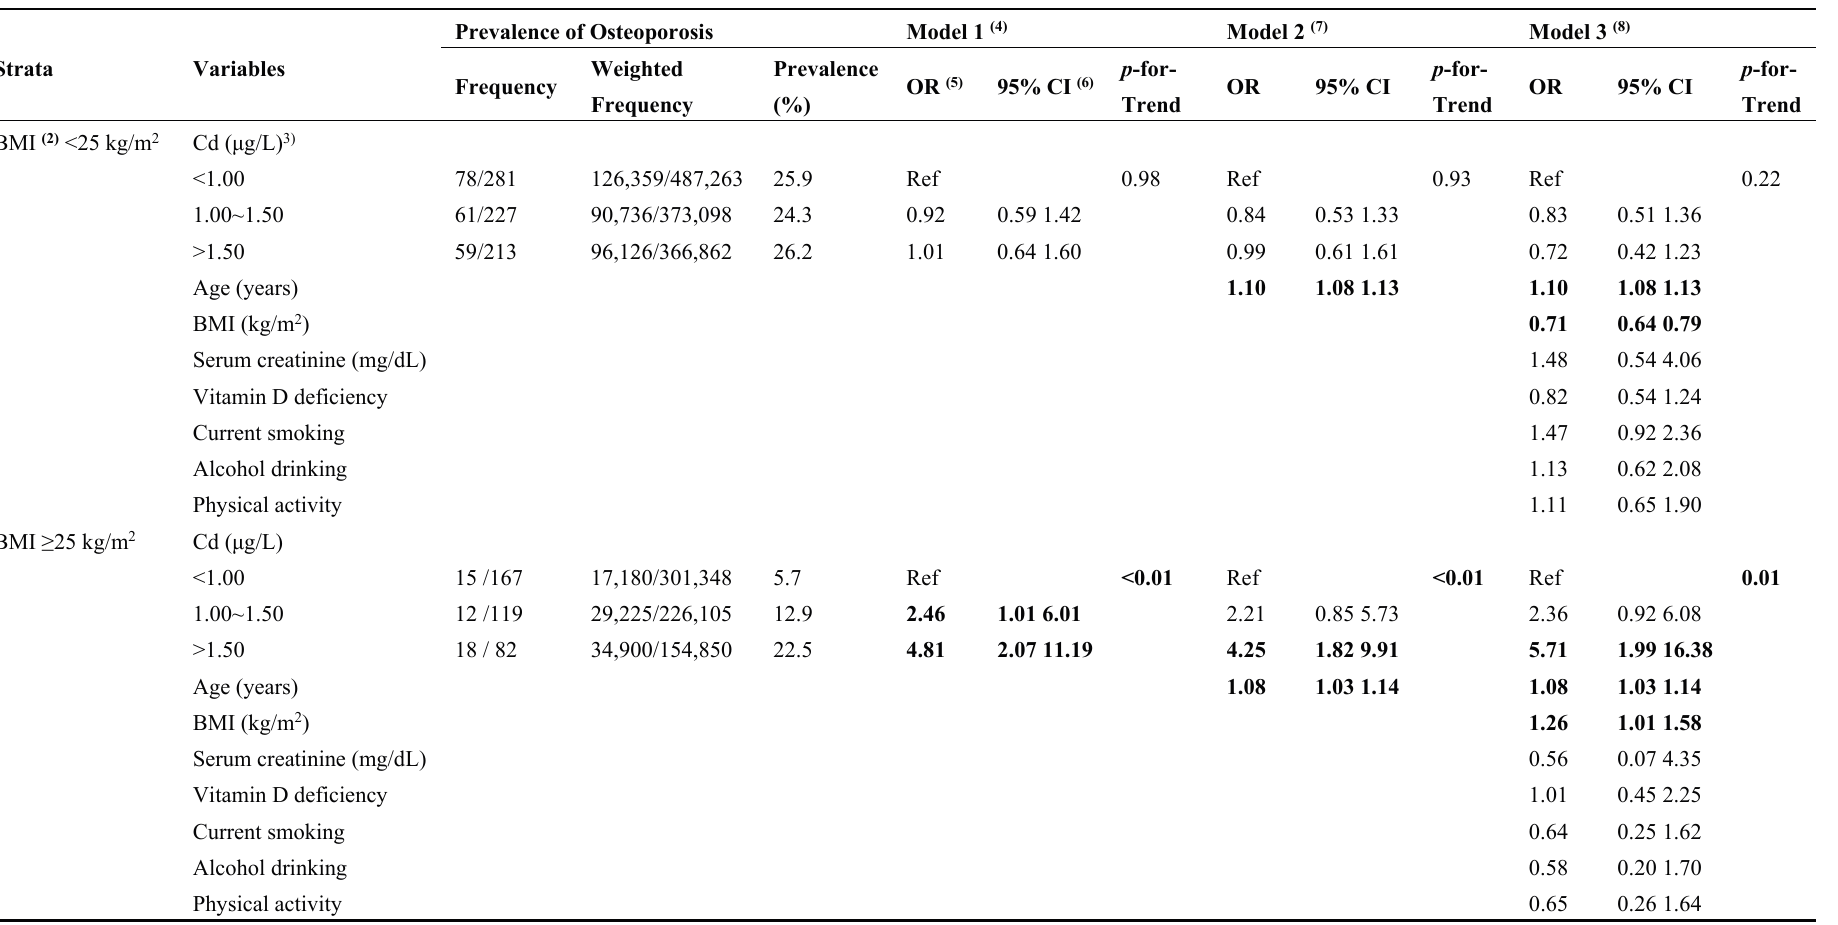
Table 4. Effects of blood cadmium on osteoporosis (1) (results of logistic regression analysis using the Korean reference for osteoporosis). Strata